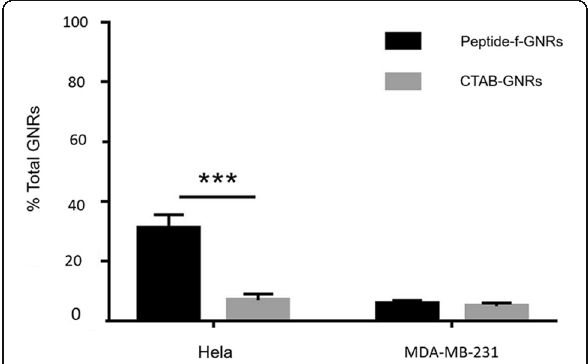
Fig. 6 Quantification of internalized GNRs (CTAB-GNRs and peptide-f-GNRs) in HeLa and MDA-MB-231 cells by atomic absorption spectroscopy (AAS). The cells were incubated with 0.35nM GNRs for 2 h. After washing the cells extensively, and lysing by aqua regia, the total gold content in the different wells was measured by AAS. HeLa and MDA-MB-231 cells showed different uptake behavior.* P <0.05; ** P <0.01; *** P